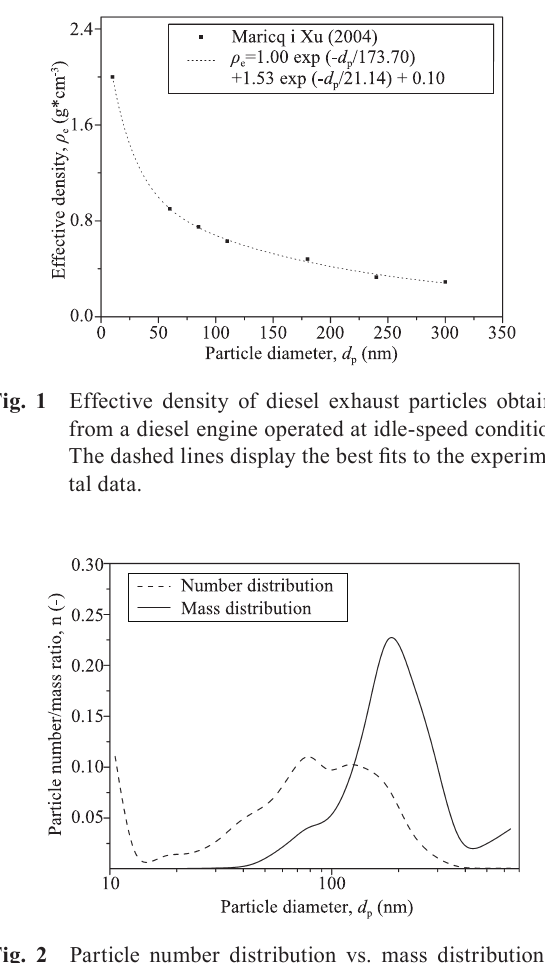
Fig. 2 Particle number distribution vs. mass distribution. A commercial diesel biofuel was used to generate particles.